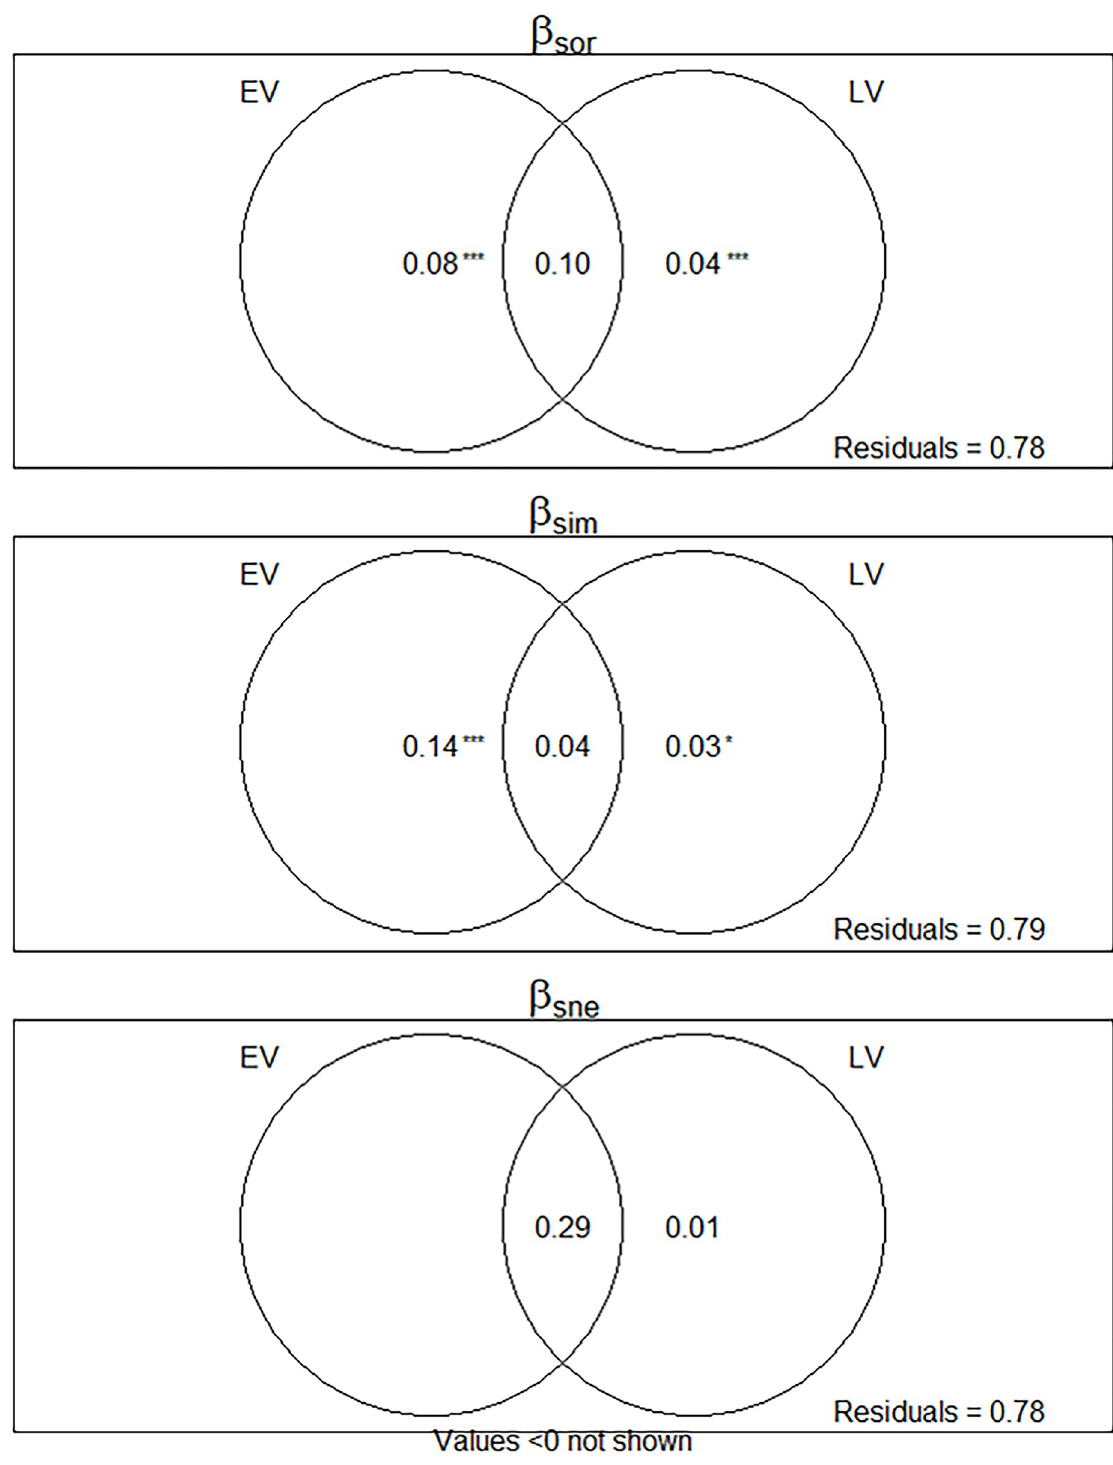
Fig 5. Venn diagrams of variation partitioning of β sor , β sim and β sne explained by environmental variables and landscape variables. Values in circles represent partitions of variation explained by variable subsets. Areas of overlap between circles represent shared variation between variable subsets. Variable fractions coded by initials: EV = Environmental variables (salinity, coarse sand chlorophyll- a , very coarse sand) and LV = Landscape variables (distance and split).